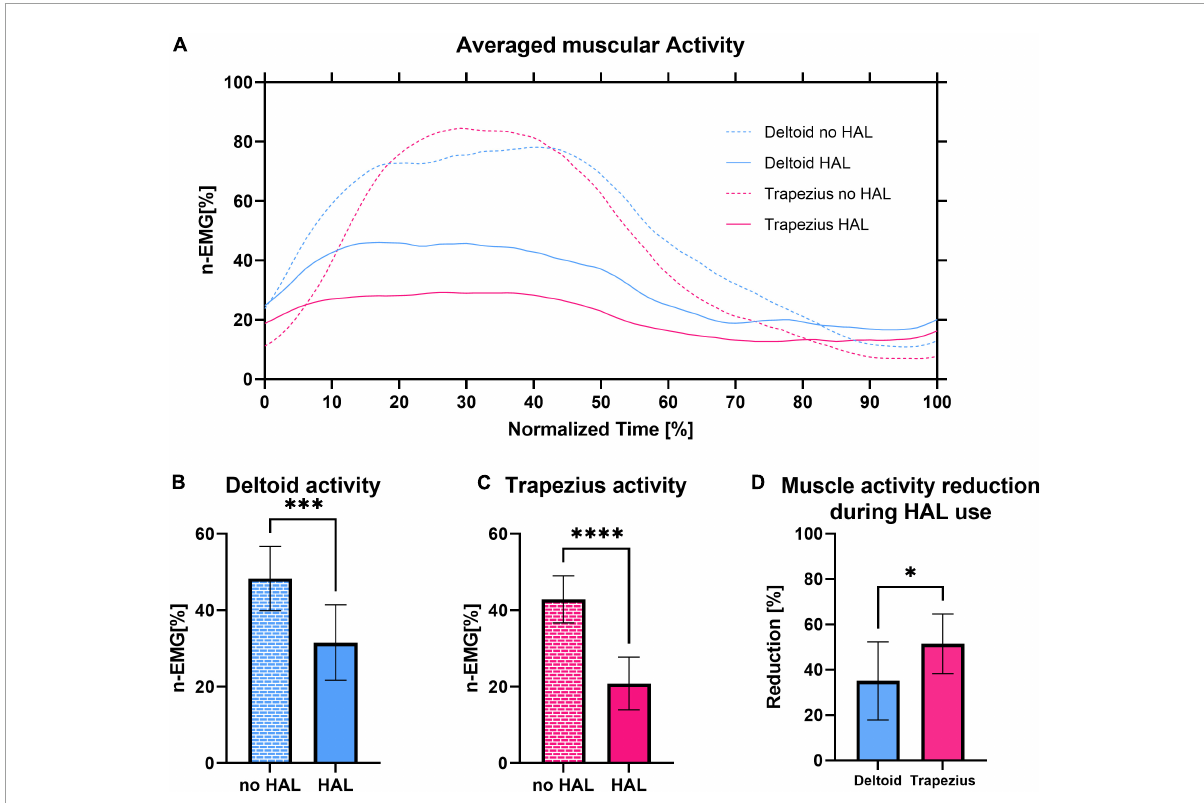
FIGURE5 (A) Integrated electromyography profiles of deltoid activity without and with shoulder HAL of all patients averaged to a shoulder elevation cycle. (B) Normalized activity of the deltoid with and without HAL. (C) Normalized activity of the trapezius with and without HAL. (D) Comparison of deltoid and trapezius activity reduction during HAL